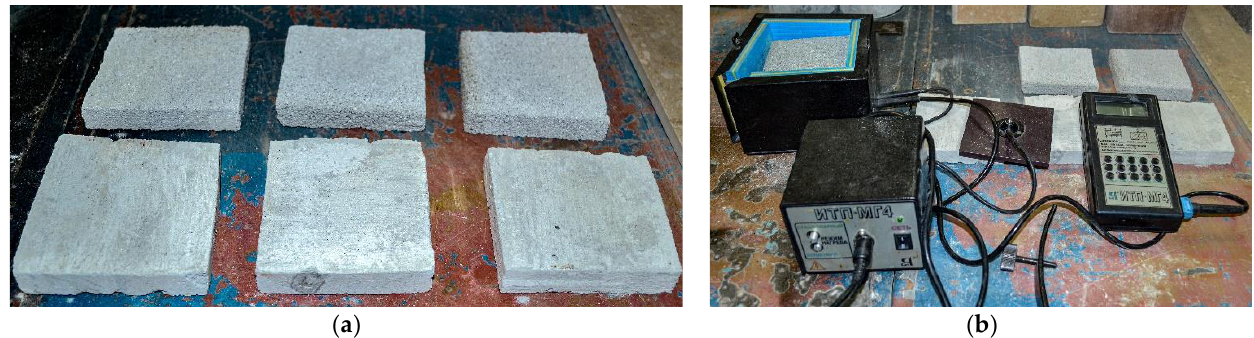
Figure 2. Specimens ( a ) and device ( b ) for testing aerated concrete for thermal conductivity.